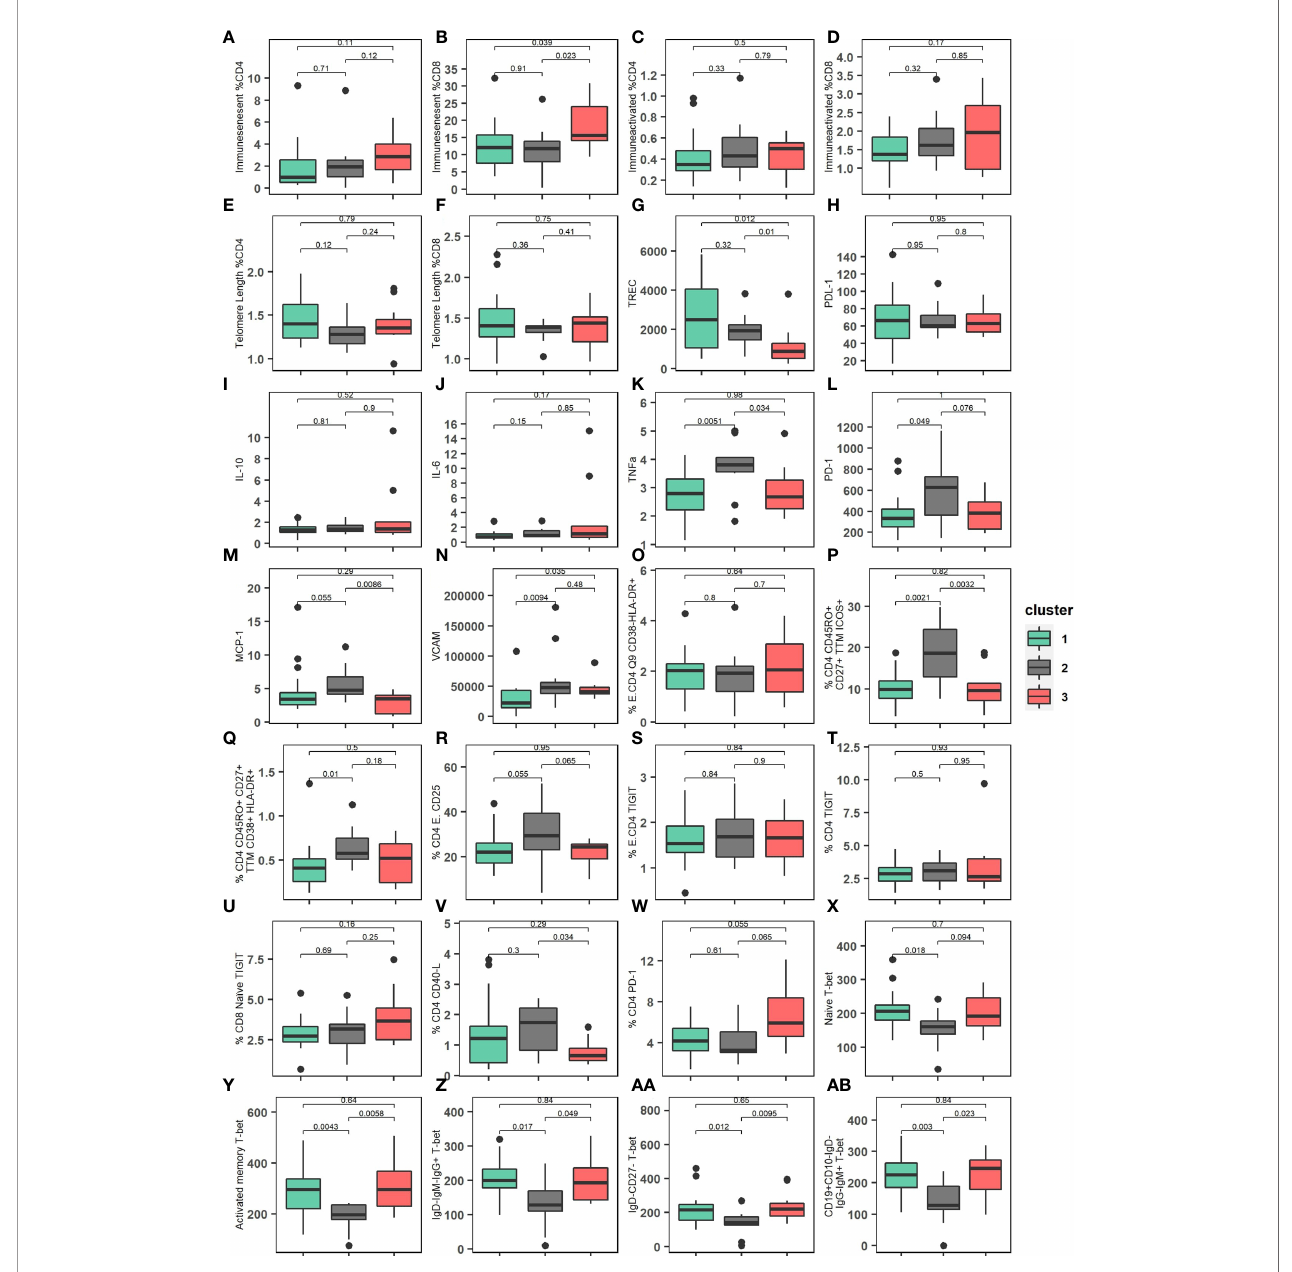
FIGURE 4 | Immunological characteristics of the three clusters described. (A) Percentage of immunosenescent CD4 cells among the clusters. (B) Percentage of immunosenescent CD8 cells among the clusters. (C) Percentage of immunoactivated CD4 cells among the clusters. (D) Percentage of immunoactivated CD8 cells among the clusters. (E) Relative Telomere length of percentage of CD4 cells among the clusters. (F) Relative Telomere relative length of percentage of CD8 cells among the clusters. (G) TREC (T-cell receptor rearrangement excision circle) levels/10 5 PBMC among the clusters. (H) PDL-1 expression among the clusters. (I) IL-10 (pg/mL) expression among the clusters. (J) IL-6 (pg/mL) expression among the clusters. (K) TFN-alpha (pg/mL) expression among the clusters. (L) PD-1expression among the clusters. (M) MCP-1 (pg/mL) expression among the clusters. (N) VCAM (pg/mL) expression among the clusters. (O) Percentage of Effector CD4 T cell expression CD38- HLA-DR+ among the clusters. (P) Percentage of CD4 expression CD45RO+ CD27+ TTM ICOS+ among the clusters. (Q) Percentage of CD4 CD45RO+ CD27+ TTM CD38+ HLA-DR+ among the clusters. (R) Percentage of Effector CD4 CD25+ among the clusters. (S) Percentage of Effector CD4 TIGIT receptor among the clusters. (T) Percentage of CD4 TIGIT receptor among the clusters. (U) Percentage of CD8 Naïve TIGIT receptor among the clusters. (V) Percentage of CD4 CD40-L among the clusters. (W) Percentage of CD4 PD-1 among the clusters. (X) Distribution of Naïve CD4 T-bet expression among the clusters. (Y) Distribution of Activated memory CD4 T-bet expression among the clusters. (Z) Distribution of Resting memory IgD- IgM- IgG- T-bet expression among the clusters. (AA) Distribution of IgD- CD27- T-bet expression among the clusters. (AB) Distribution of CD19+CD10-IgD-IgG-IgM+ T-bet expression among the clusters. P-values were calculated using Kruskal-Wallis